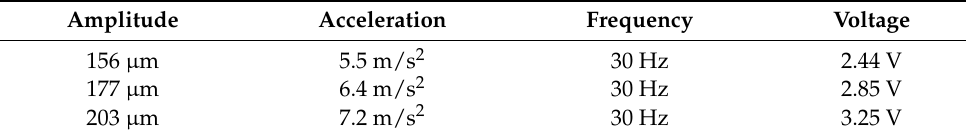
Table 3. Accelerations, amplitudes, and input voltages of the vibratory stimuli used in Experiment 2.